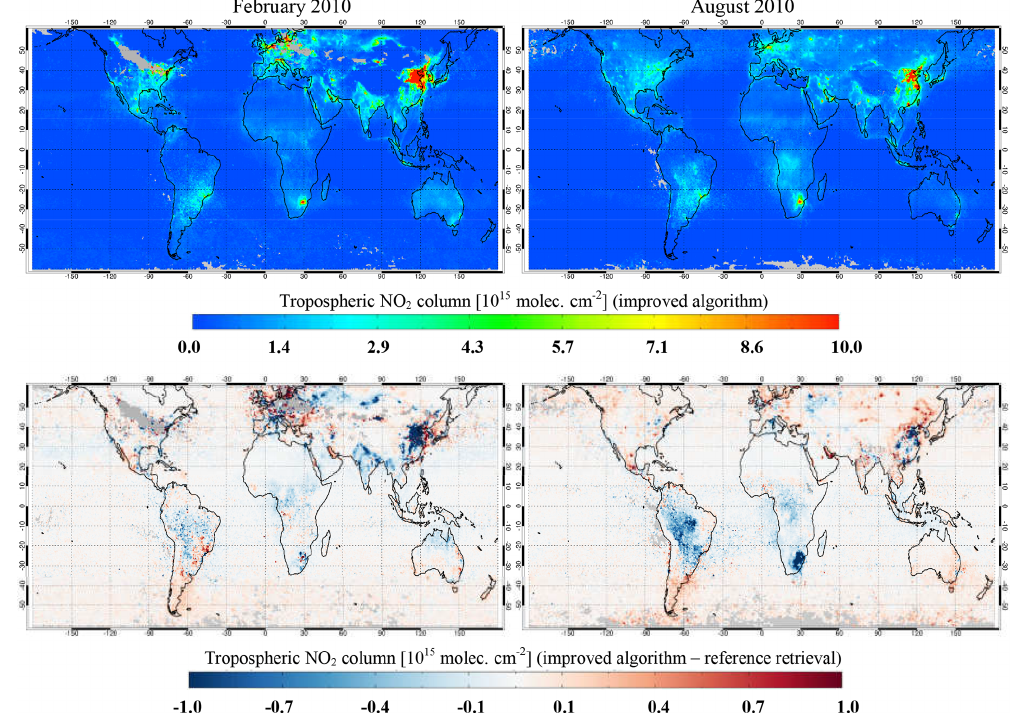
Figure 13. GOME-2 tropospheric NO 2 columns retrieved using the improved algorithm, and the differences from the reference data in February and August 2010. Only measurements with a cloud radiance fraction less than 0.5 are included. Cloud observations with a fitting rms greater than 1 × 10 − 4 or a number of iterations greater than 20 are filtered